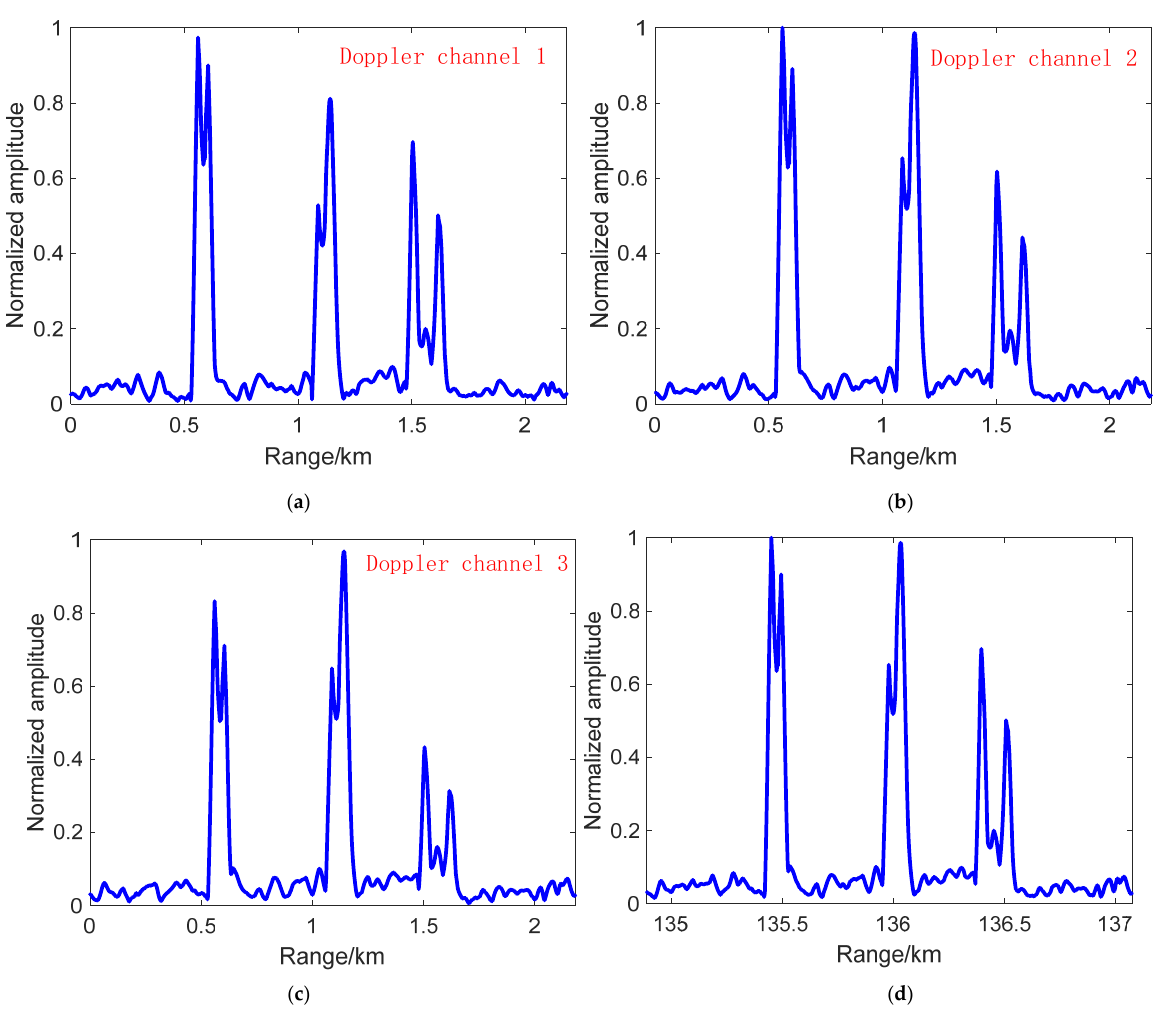
Figure 11. Doppler compensation comparison of method 1 in a one-dimensional range image using B3I signals of satellite 3: ( a ) Results with Doppler channel 1 compensation; ( b ) results with Doppler channel 2 compensation; ( c ) results with Doppler channel 3 compensation; ( d ) results with the proposed MTDC method based on multiple Doppler channels.